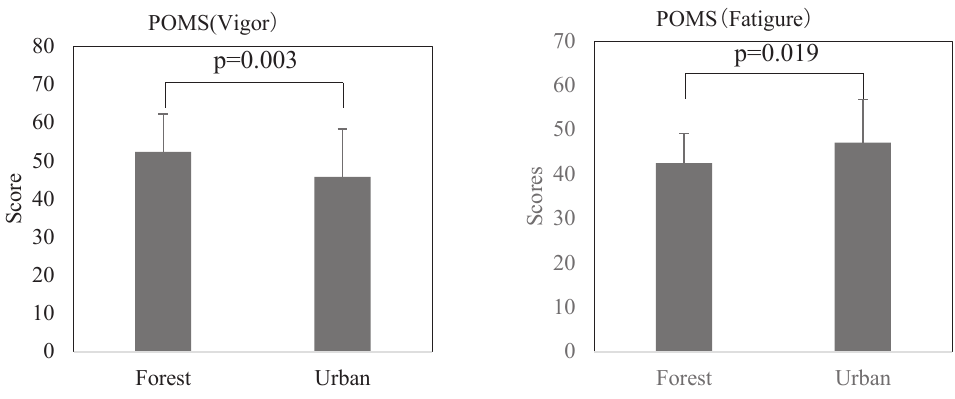
Fig. 4 E ff ect of forest bathing on vigor and fatigue in the POMS test. “ Forest ” means after walking in the forest (forest bathing) and “ Urban ” means after walking in the urban area. p = 0.003 forest vs urban for vigor, p = 0.019 forest vs urban for fatigure by paired t-test (Mean + SD, n = 20)